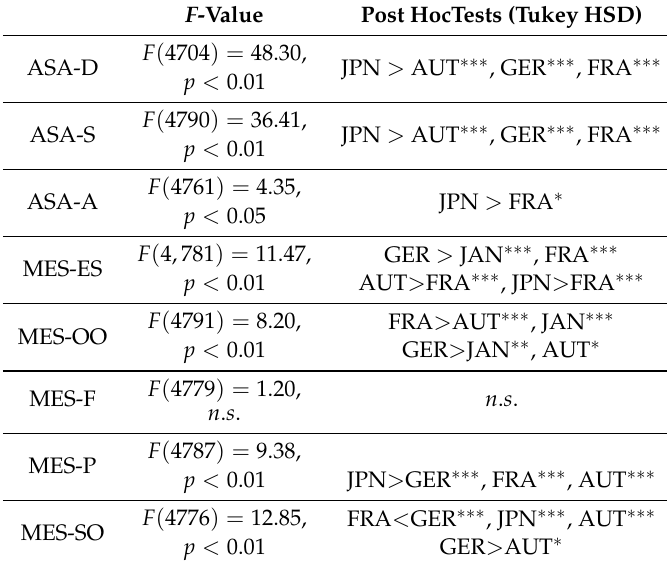
Table 4. Summary of ASA and MES scores. ASA: animism scale for adults; MES: